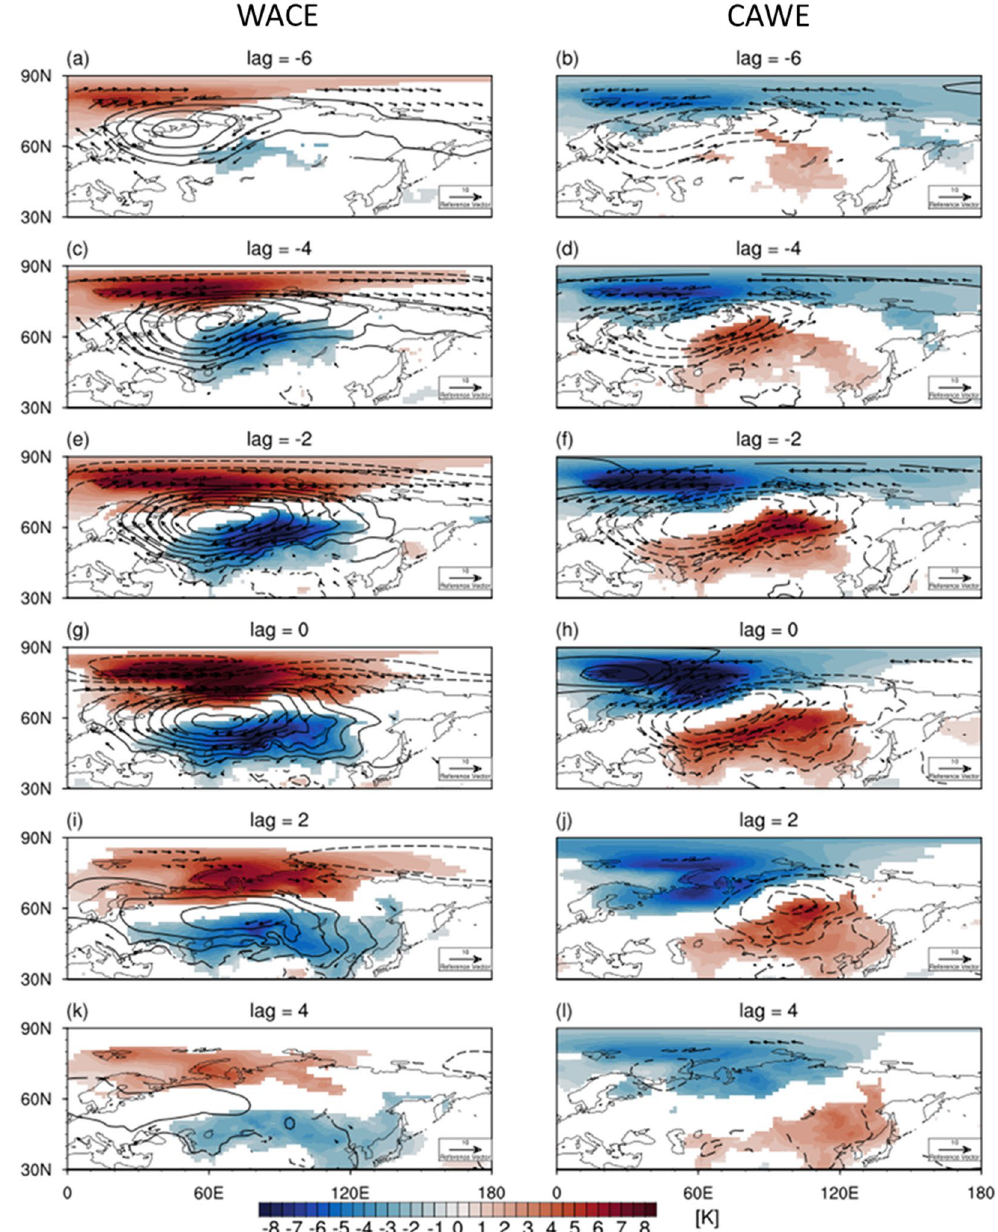
Figure 2. The lead-lag composite mean of SAT (shaded) and SLP (contour) anomalies and wind (vector) anomalies at 850 hPa for (left) WACE and (right) CAWE cases at lags ( a , b ) -6 days, ( c , d ) -4 days, ( e , f ) -2 days, ( g , h ) 0 days, ( i , j ) 2 days, and ( k , l ) 4 days with respect to the local maximum of DI. The contour interval for SLP anomalies is 2 hPa and the negative values are contoured in dashed line. Only the values that are statistically significant at the 95% confidence level are shaded. Figures were created with the NCAR Command Language 6.6.2 (http://dx.doi.org/10.5065/D6WD3